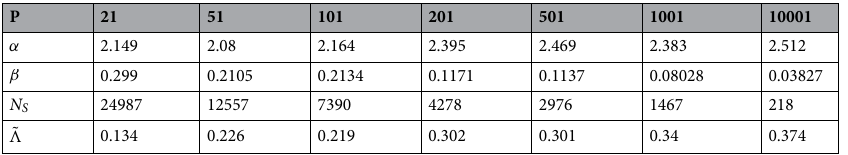
˜ (cid:31) , for each population size.